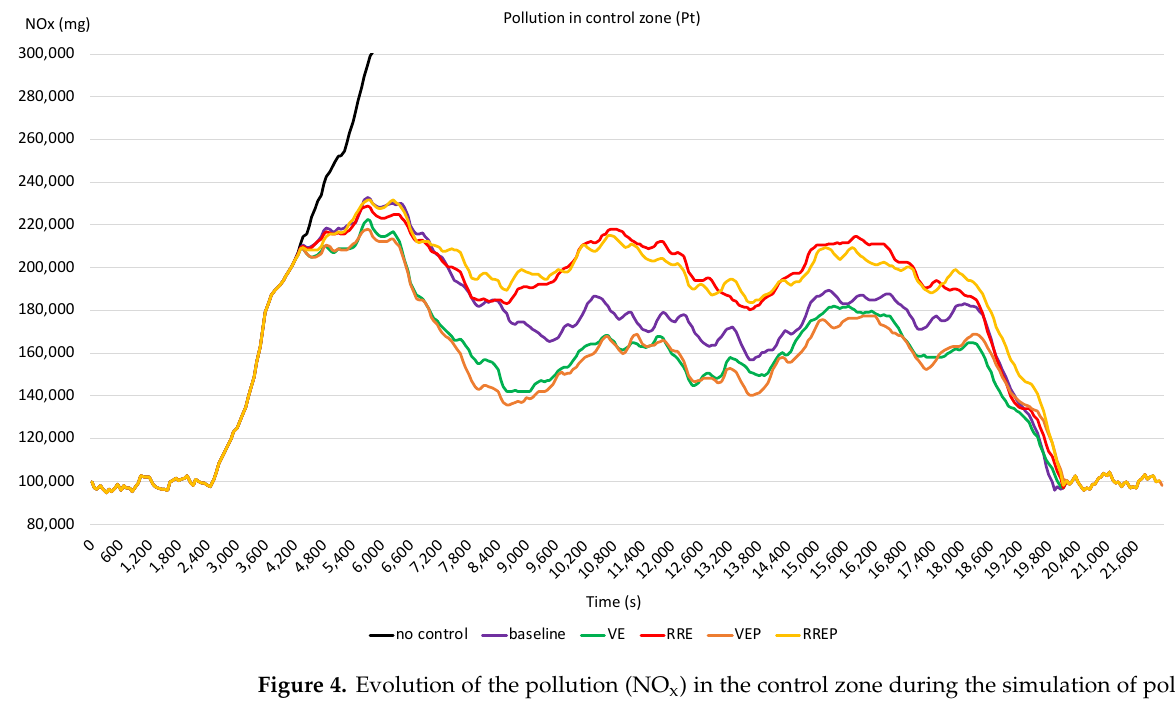
Figure 4. Evolution of the pollution (NO x ) in the control zone during the simulation of pollution- based access with constant arrival rates.